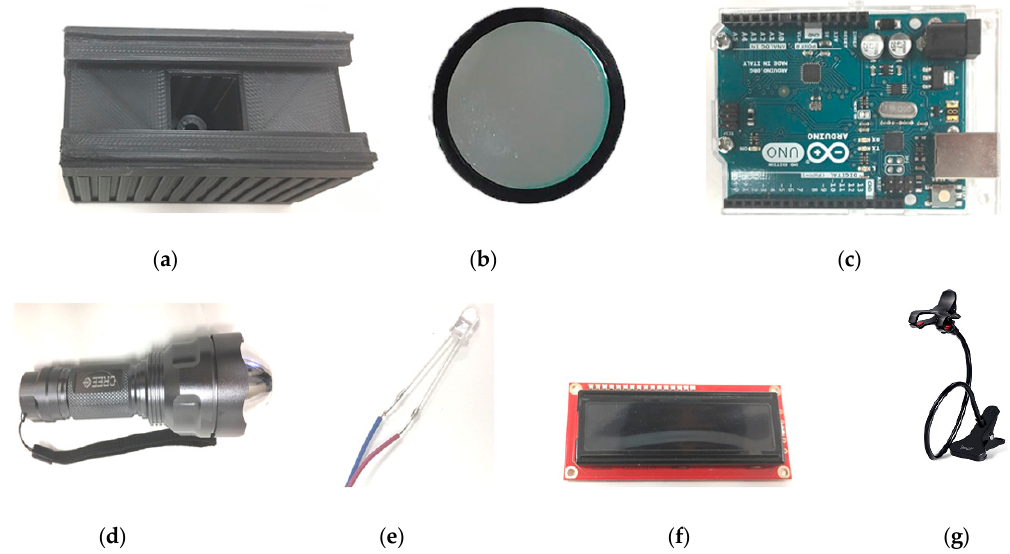
Figure 2. Off-the-shelf commercial components used to construct the prototype: ( a ) 3D printed sample chamber, ( b ) longpass filter, ( c ) microcontroller (Arduino Uno), ( d ) flashlight, ( e ) photodiode, ( f ) LCD display, and ( g ) holder (images are not to scale).